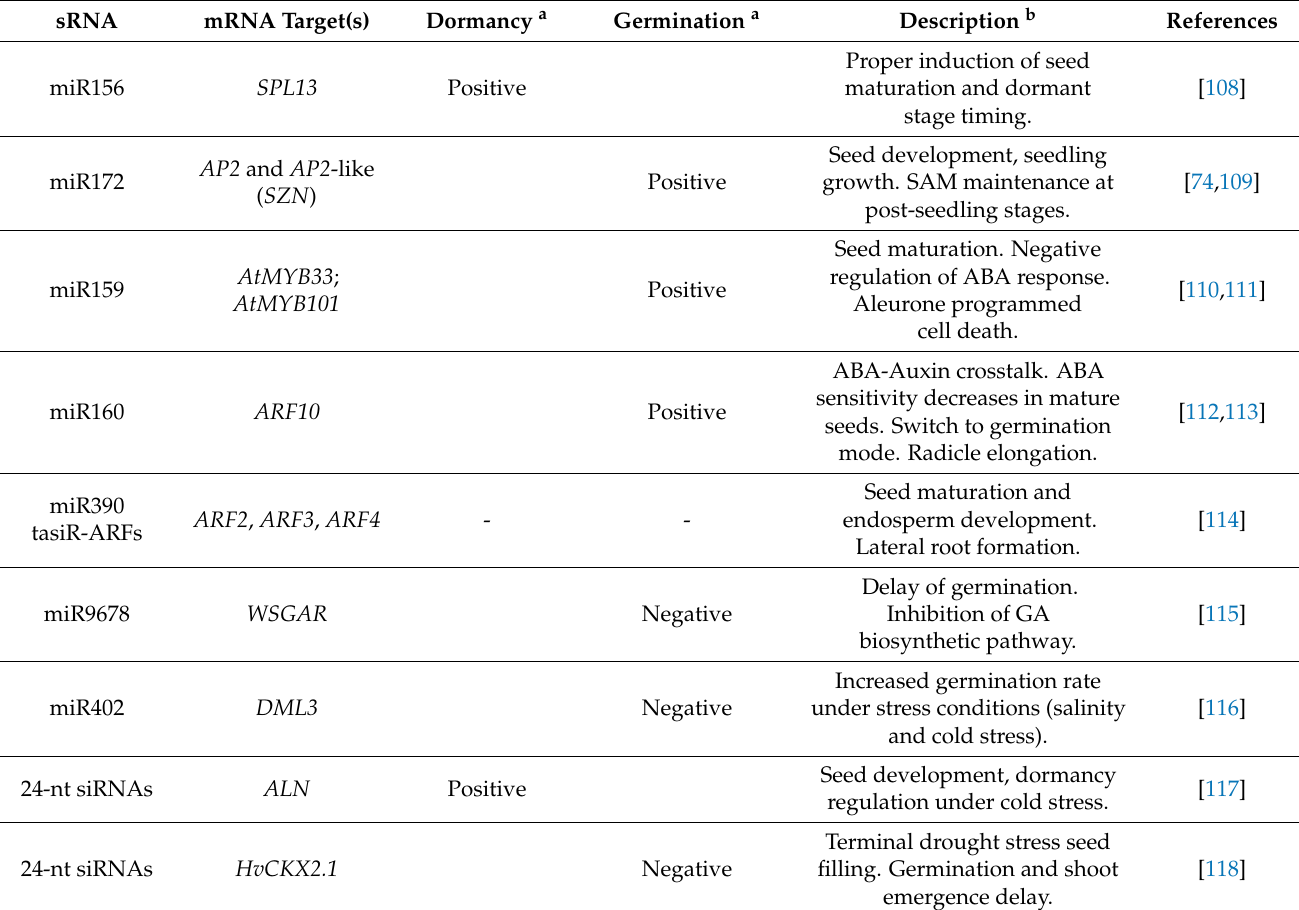
Table 1. sRNAs involved in seed dormancy and